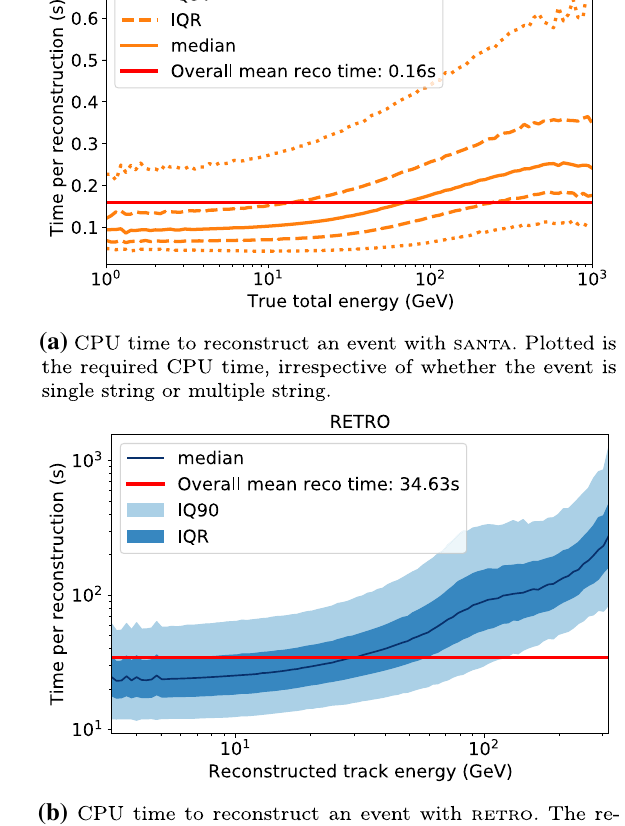
Fig. 18 Reconstructions CPU time to estimate the event parameters. The median together with the 50 and 90 percent interquantile range (IQR and IQ90) are plotted for different energies. The overall mean time is also shown as an indication of how long it takes to reconstruct a certain number of events for the event distribution used